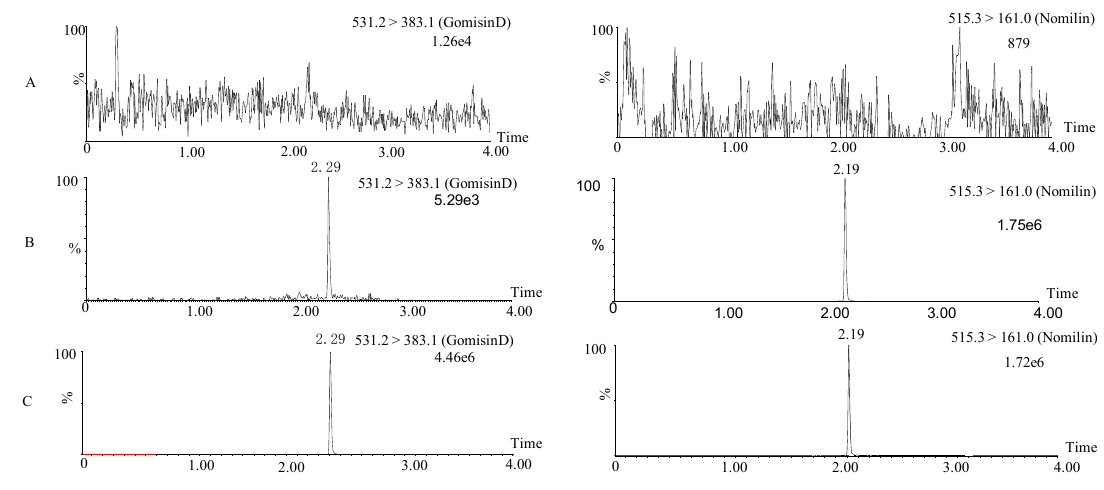
Figure 2. Typical ultra-performance liquid chromatography/tandem mass spectrometry (UPLC-MS) chromatograms of gomisin D and internal standard (IS). Rat blank plasma ( A ); rat blank plasma spiked with 1 ng/mL of gomisin D ( B ); plasma sample collected 30 min after intravenous administration of a single 5 mg/kg dose of gomisin D ( C ). Table 1. Extraction recovery and matrix effect of gomisin D and nomilin in rat plasma (mean ± SD, n = 6). Nominal Concentration (ng/mL)